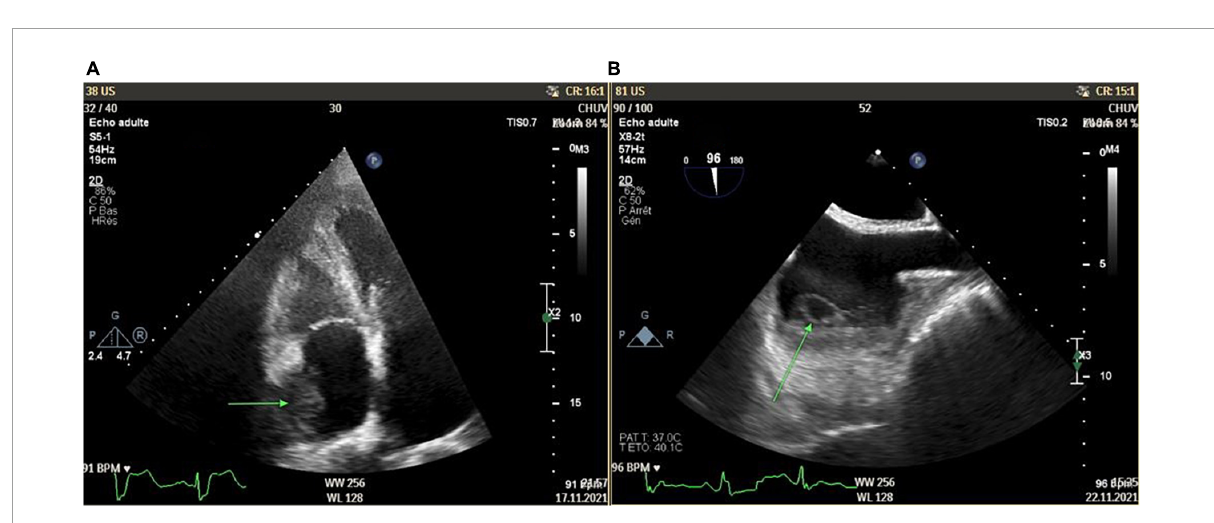
FIGURE2 Right atrium mass (15 × 18 mm) with thickened lateral wall without associated tricuspid valve anomalies as shown in transthoracic echocardiography [green arrow, Panel (A) ] and transesophageal echocardiography [green arrow, Panel (B)